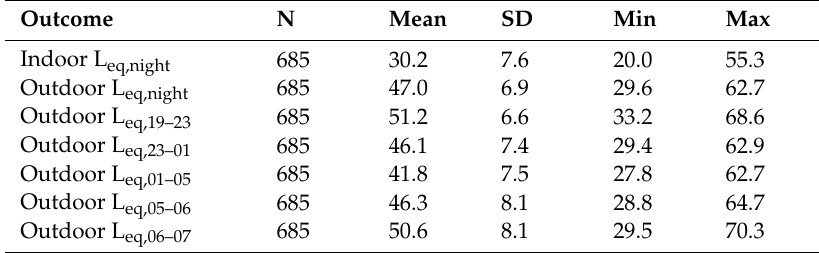
Table 2. Overview of the noise exposure data in dB(A) (for intermittency ratio (IR), see Supplementary Table S2).